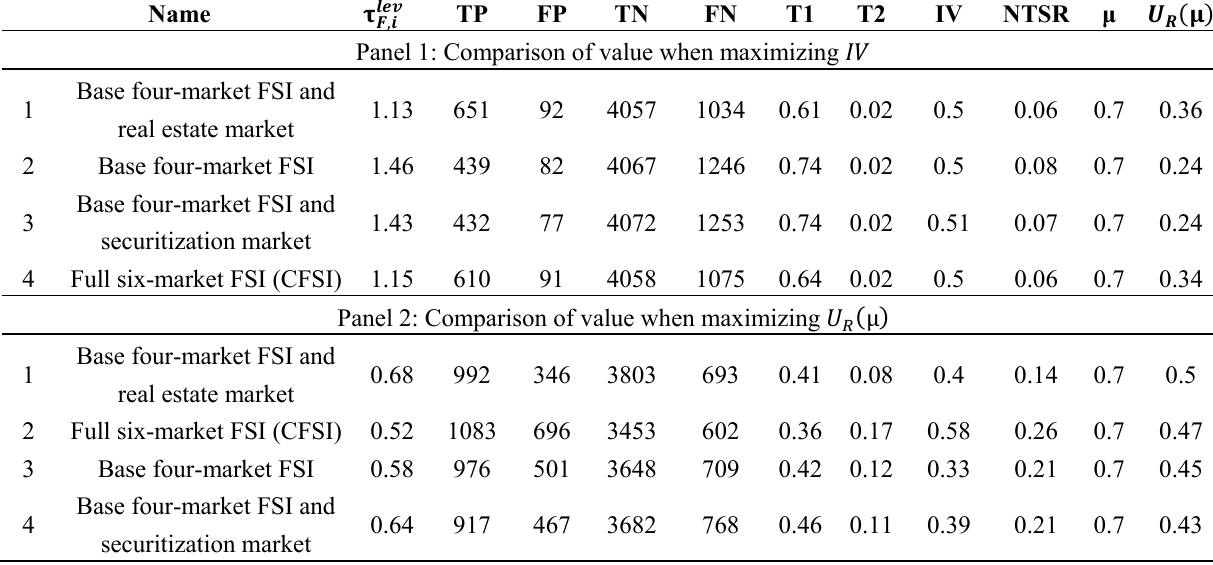
Table 2. Estimating the value of information provided by variations of the FSI. Panel 1: Comparison of value when maximizing